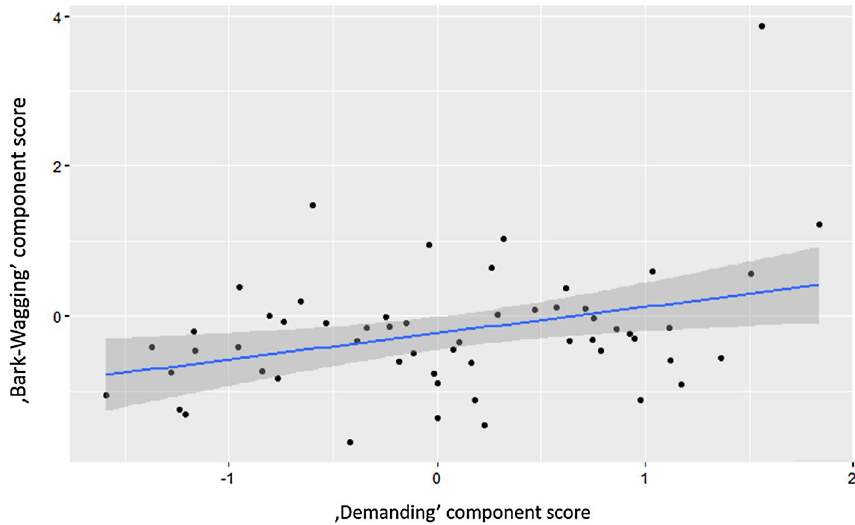
Figure 2. The relationship between ‘Demanding’ and ’Bark–Wagging’ component score.